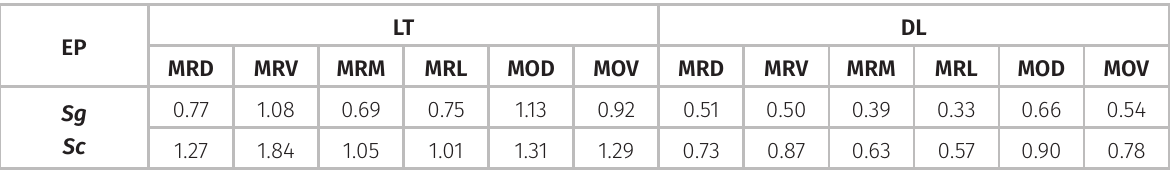
Table II. Length of extraocular muscles at their insertions, in centimeters. LT DL EP MRD MRV MRM MRL MOD MOV MRD MRV MRM MRL MOD MOV 0.77 1.08 Sg Sc Sg = Sotalia guianensis ; Sc = Stenella clymene ; EP = species; LT = width of the tendons in insertion in the sclera; DL = Distance from the limbus to the insertion in the sclera; MRD = dorsal rectum; MRV = ventral rectum; MRM = medial rectum; MRL = lateral rectum; MOD = dorsal oblique; MOV = ventral